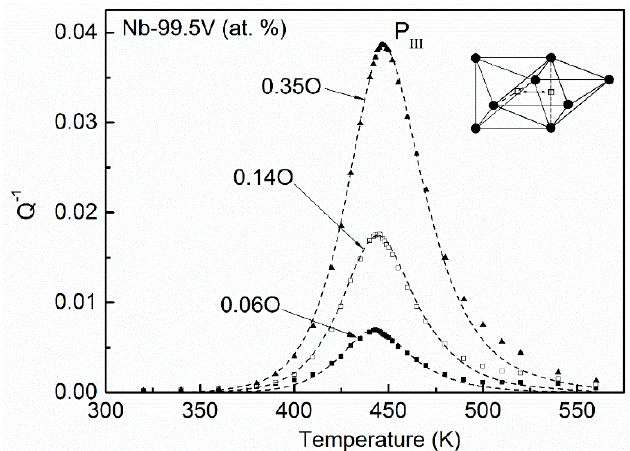
Figure 12. Temperature dependence of the relaxation peak and the fitting results for Nb–99.5V alloys with 0.06, 0.14, and 0.35 at. % O (points—experimental; dashed line—fitted elementary peaks using a single Debye process). ( ○ —Nb atoms, ● —V atoms).